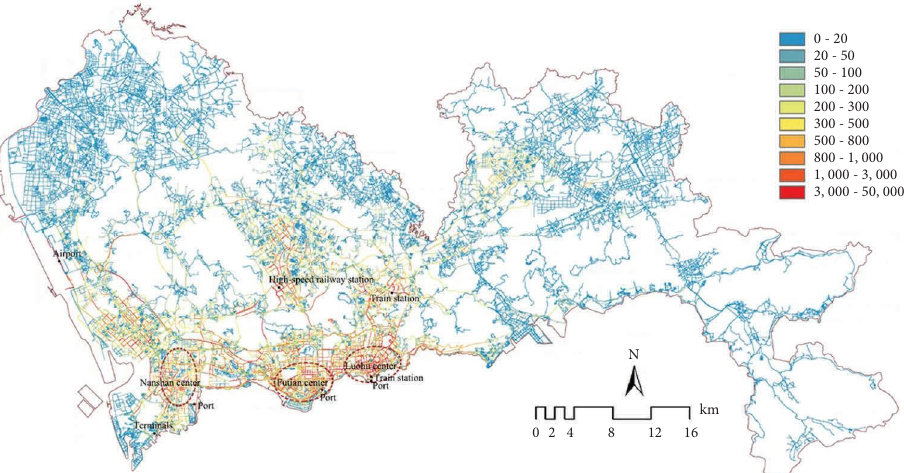
Figure 10: Frequency of taxi pick-up and drop-of activities in Shenzhen from October 17 to October 23, 2017.